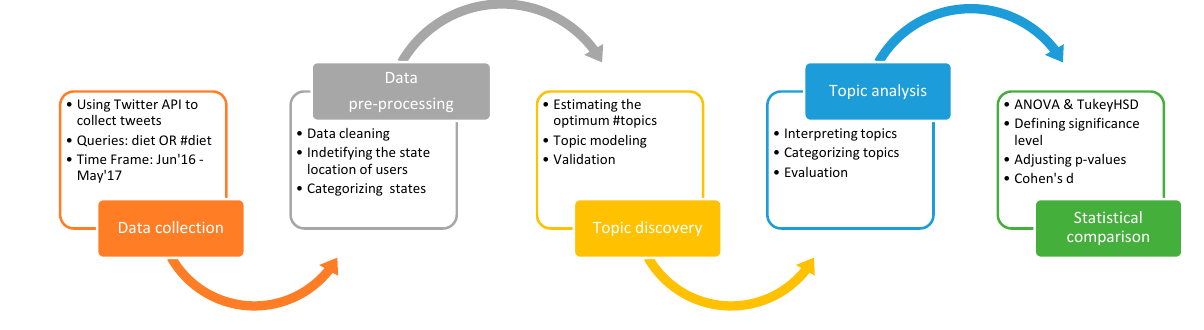
Figure 1. Research Framework.